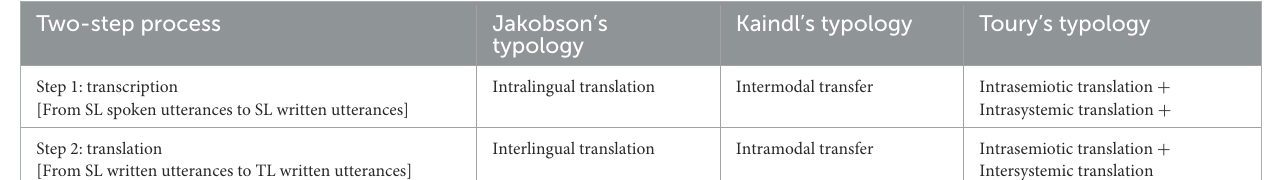
TABLE 1 FTT typologies.